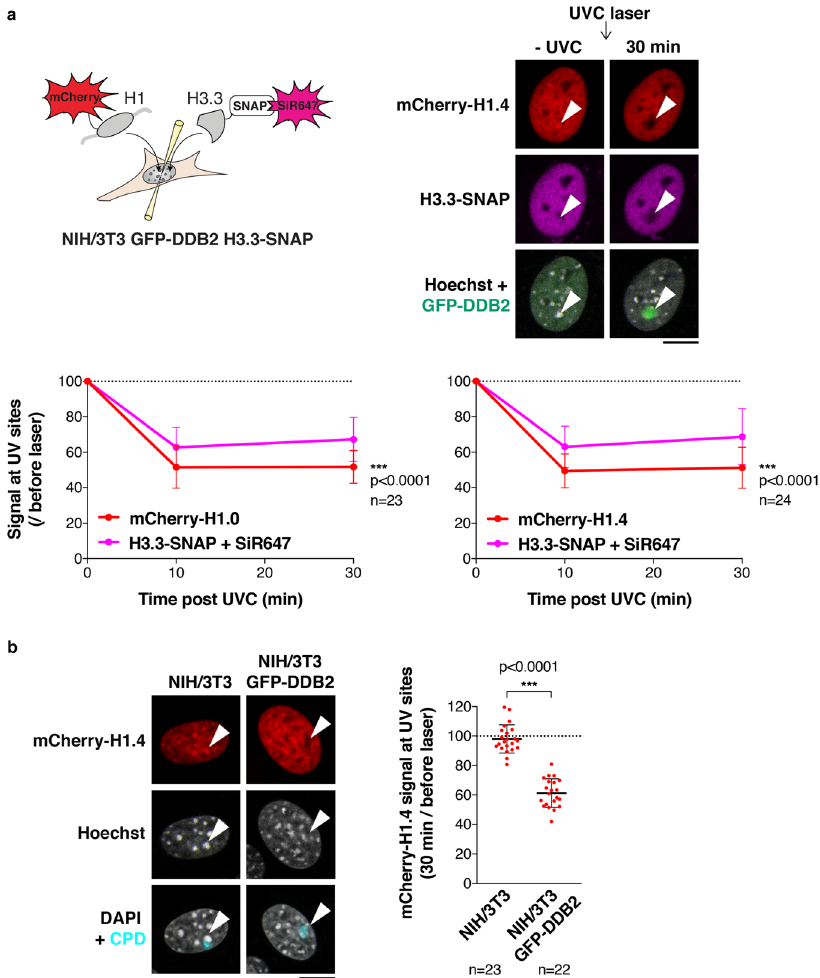
Fig. 3 The UV damage sensor DDB2 promotes linker histone displacement from damaged chromatin. a Scheme of the experiment for simultaneous detection of H1 and H3.3 in live cells exposed to UVC laser damage. H1 variants are transiently expressed as mCherry-tagged fusions in NIH/3T3 GFP- DDB2 cells stably expressing H3.3-SNAP, which is labelled with SNAP-cell SiR-647. The levels of H1 variants and H3.3 are measured in UVC-damaged regions, identi fi ed by GFP-DDB2 accumulation (white arrowheads), relative to the whole nucleus at the indicated time points after laser damage. Results normalized to before laser damage are presented on the graphs. b mCherry-H1.4 signal in damaged heterochromatin domains (white arrowheads) 30 min after UVC laser micro-irradiation analyzed by live imaging in the indicated cell lines. CPD staining in fi xed cells highlights the damaged chromocenter. The scatter plot represents the mCherry-H1.4 signal loss in UVC-damaged chromatin regions in both cell lines. Data are presented as mean values ± SD from n cells scored in at least three independent experiments. Comparisons of histone signal loss are based on non-linear regression with a polynomial quadratic model ( a ). Statistical signi fi cance in ( b ) is calculated via two-sided Student ’ s t test. Scale bars, 10 μ m. Source data are provided as a Source Data fi